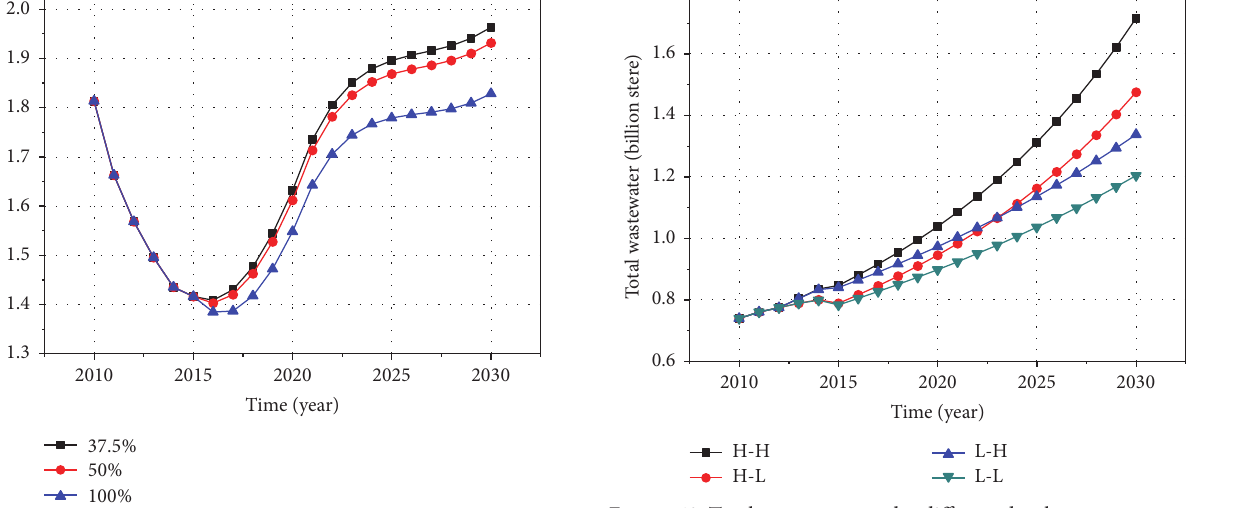
Figure 11: Water pollution under different wastewater treatment fee.